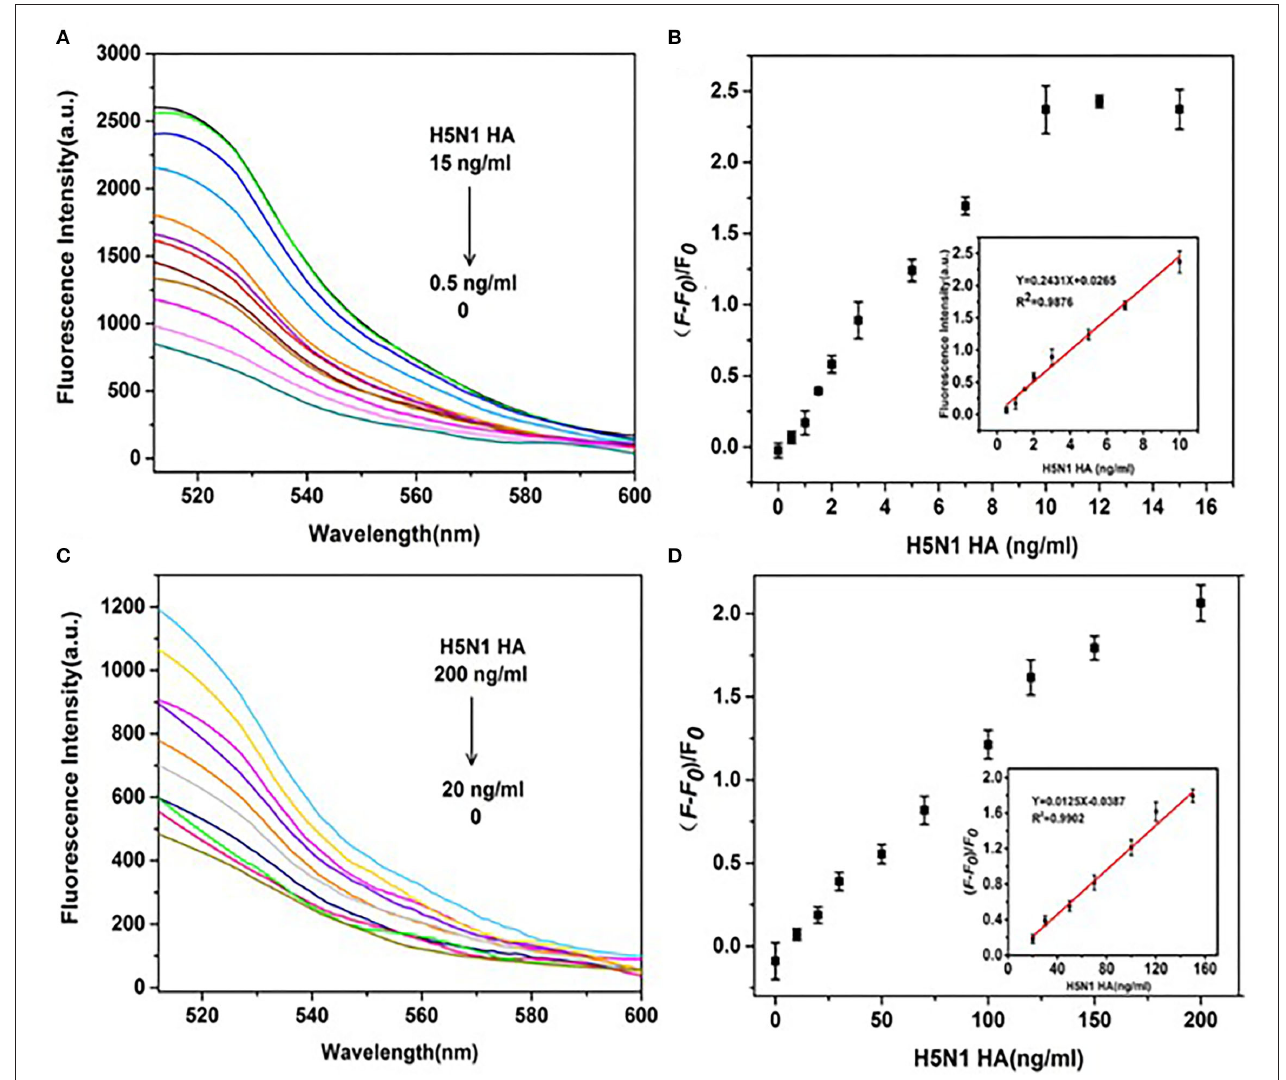
FIGURE 7 | Effects of DNase I on the sensitivity of detection of H5N1 HA. (A) Fluorescence spectra of a series of concentrations of H5N1 HA (0, 0.5, 1, 1.5, 2, 3, 5, 7, 10, 12, and 15ng/ml) in the presence of DNase I. (B) (F – F0)/F0(fluorescence change) vs. concentration of H5N1 HA in the presence of DNase I. (C) Fluorescence intensities of a series of concentrations of H5N1 HA (0, 10, 20, 30, 50, 70, 100, 120, 150, and 200ng/ml) in the absence of DNase I. (D) (F – F0)/F0 (fluorescence change) vs. concentration of H5N1 HA in the absence of DNase I. The insets show a linear relationship between (F – F0)/F0 and H5N1 HA concentration in the presence of DNase I (B) and the absence of DNase I (D)